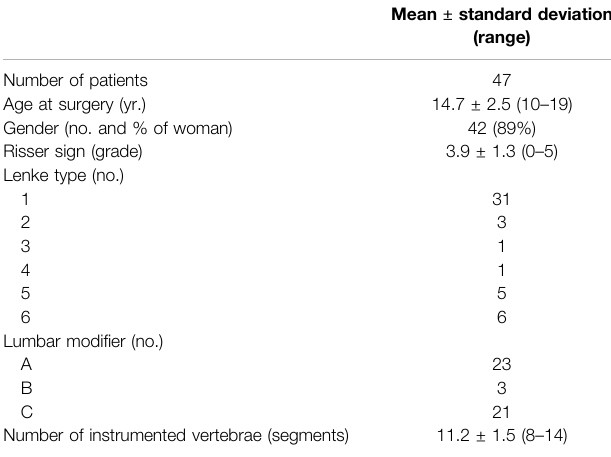
Mean ± standard deviation (range)